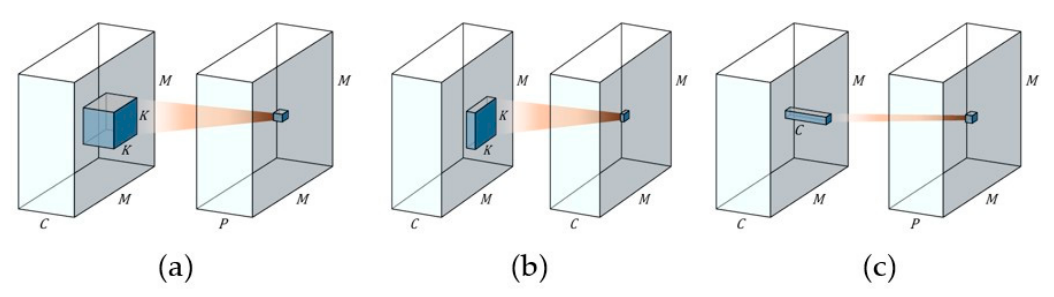
Figure 4. Several convolution methods. ( a ) general convolution, ( b ) depth-wise convolution and ( c ) point-wise convolution.